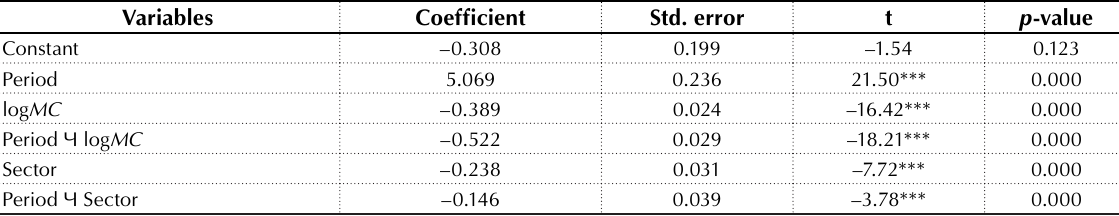
Table 6. Results of OSL regression for the liquidity measure PIILL (Model 1)